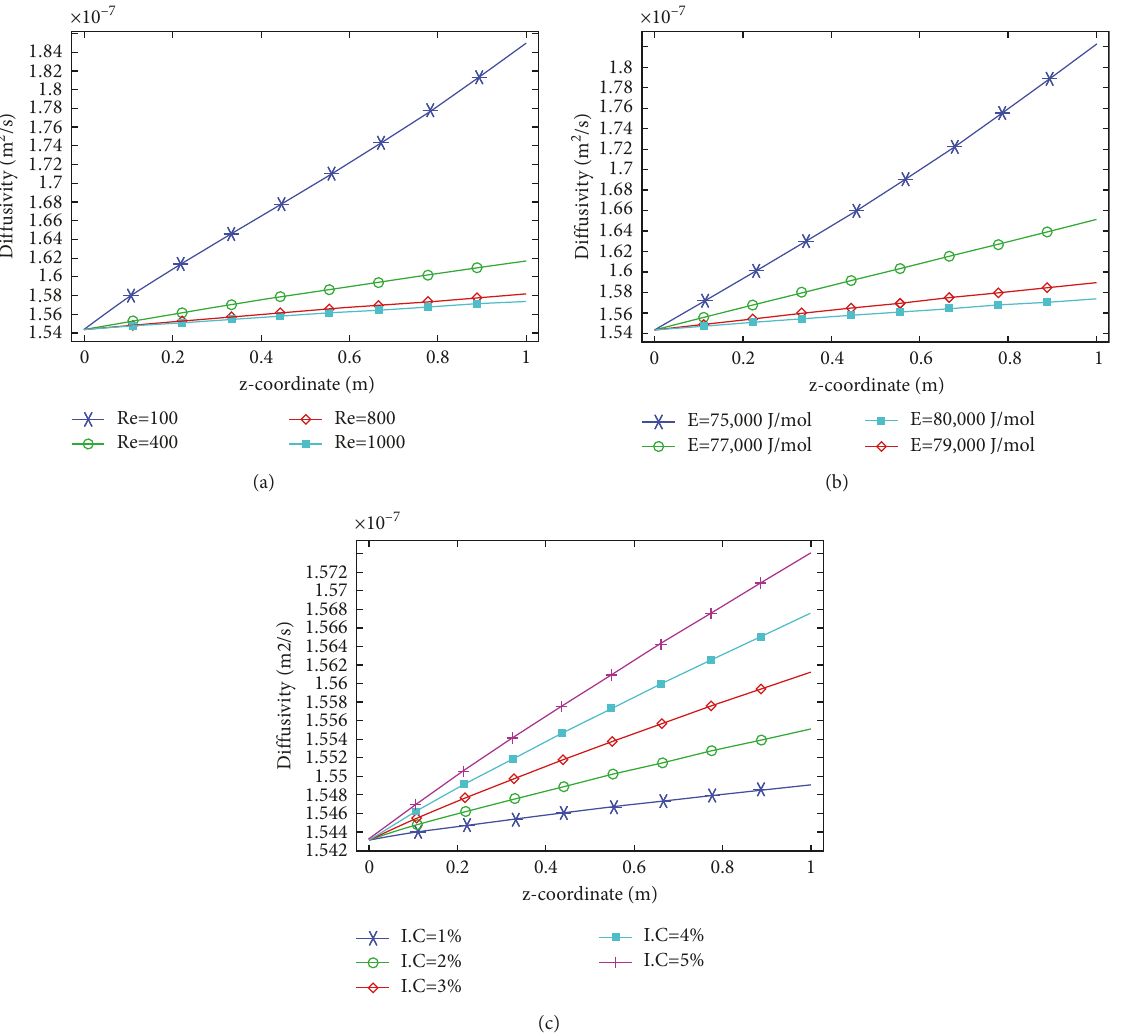
Figure 13: Diffusivity of calcium oxide in water: (a) I.C � 5%, E � 80,000J/mol; (b) I.C � 5%, Re � 1000; (c) Re � 1000, E �